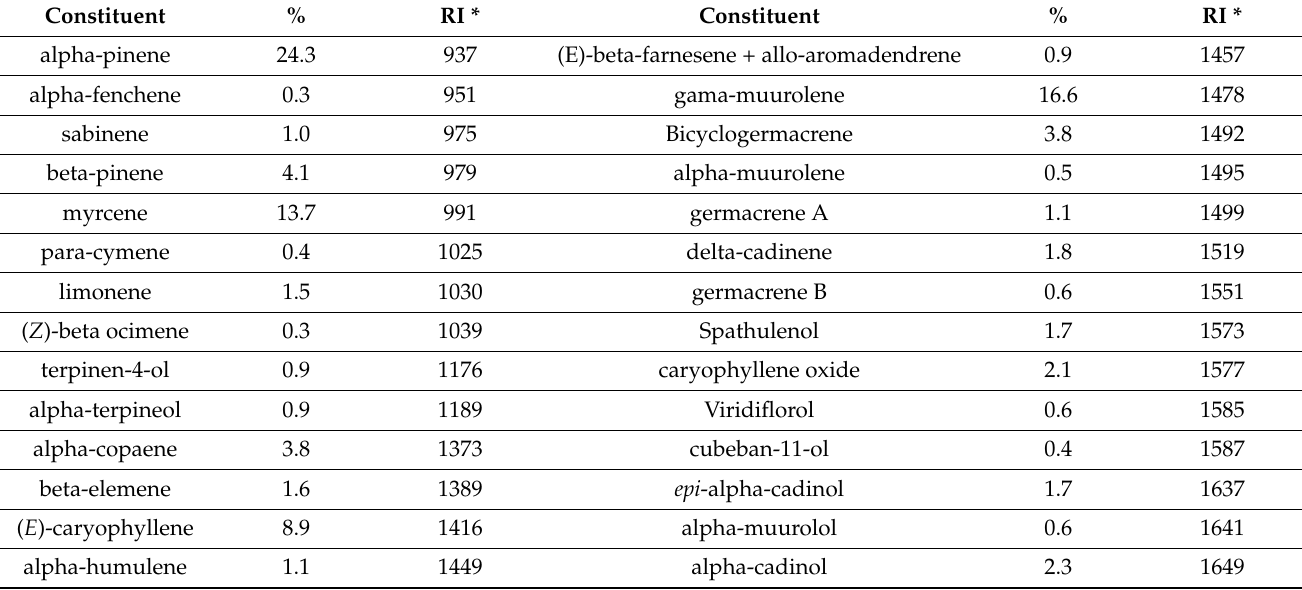
Table 1. The chemical composition of Schinus terebinthifolius Raddi essential